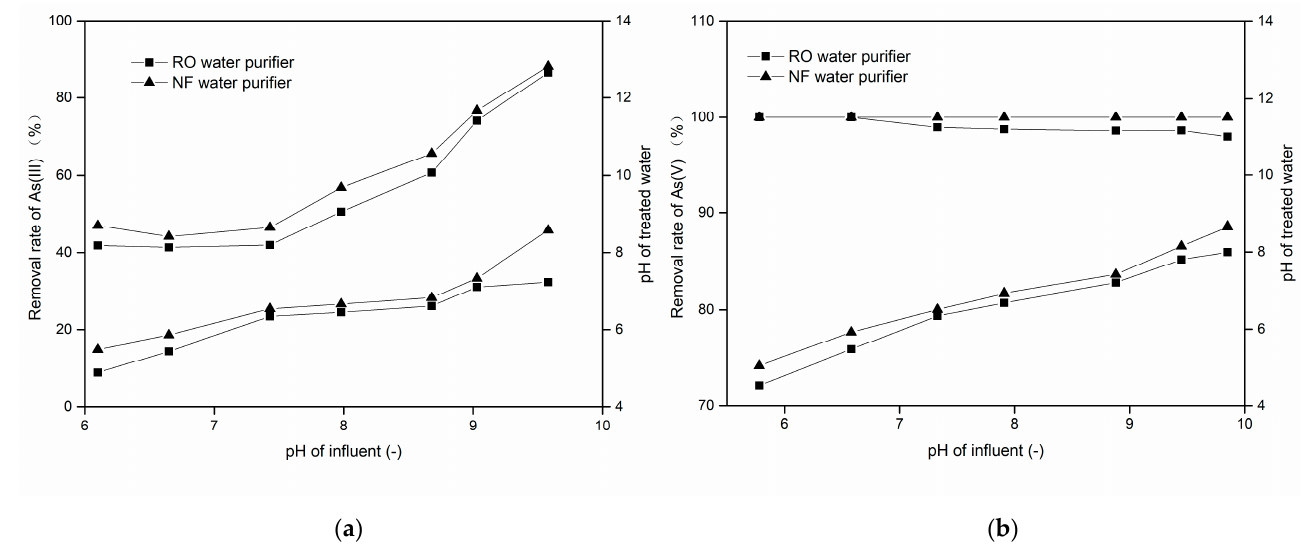
Figure 7. Effect of pH on the removal rate of ( a ) As(III), ( b ) As(V).